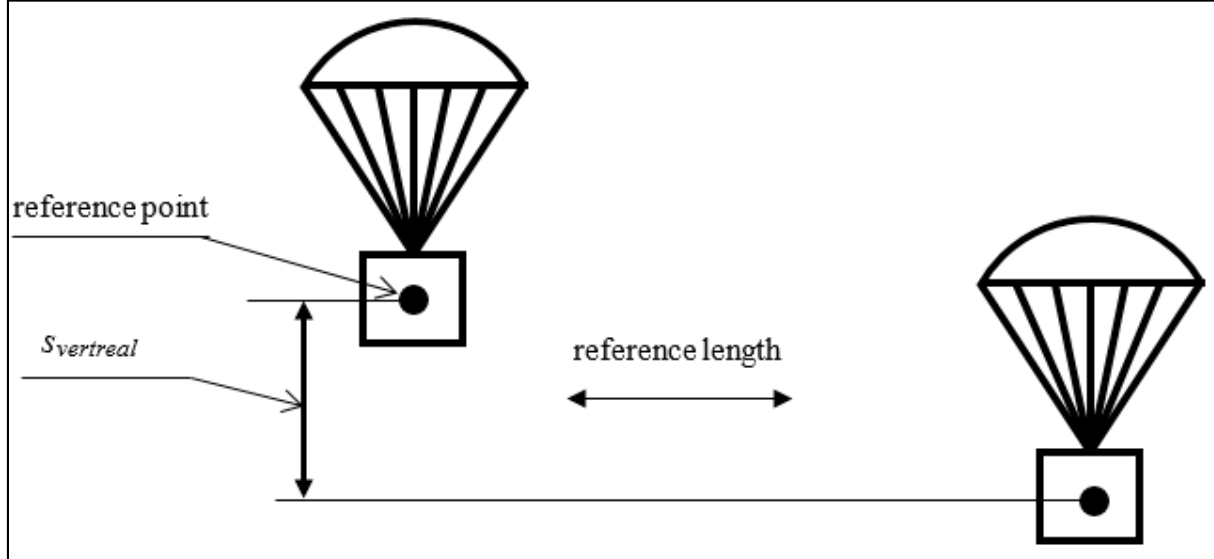
Figure 3. The measurement of the parachute vertical speed by the photo-optical method (source: The authors of this arti- cle).